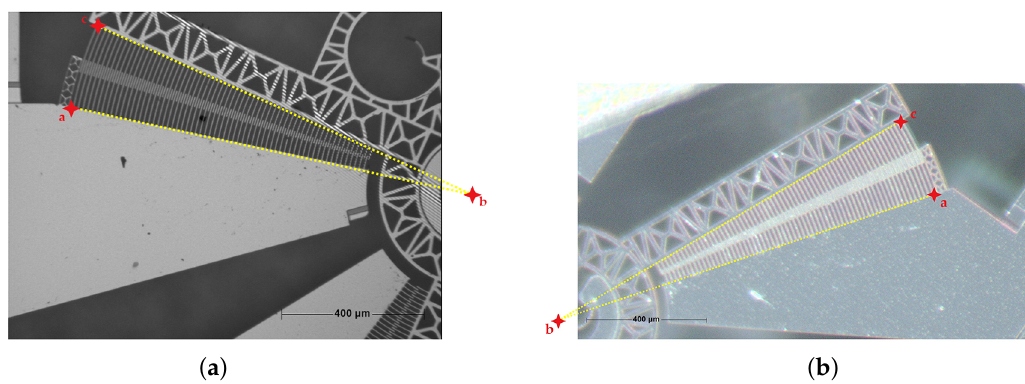
Figure 8. The determination of three points on the profilometer ( a ) and the microscope ( b ) images: the most distant point from the ICR on the fixed part of the comb-drive, the ICR of the comb-drive and the center of the ROI.